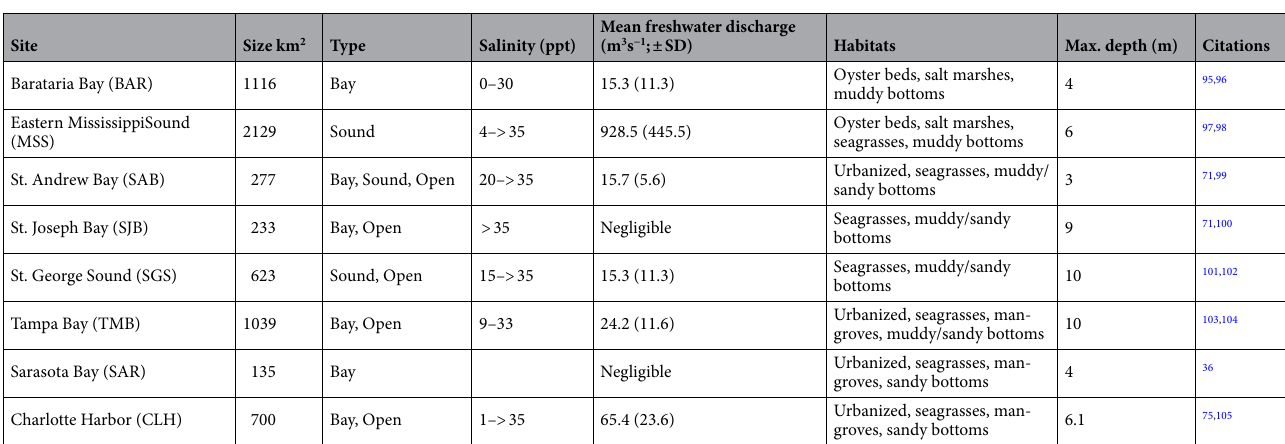
Table 1. Attributes of each sampling site, including size (embayment/water area), type (bays are enclosed, sounds are semi-enclosed, and Gulf sites are not enclosed), salinity and freshwater influence (annual average cubic meters per second for all major tributaries), habitat types, maximum depth, and citations for habitat